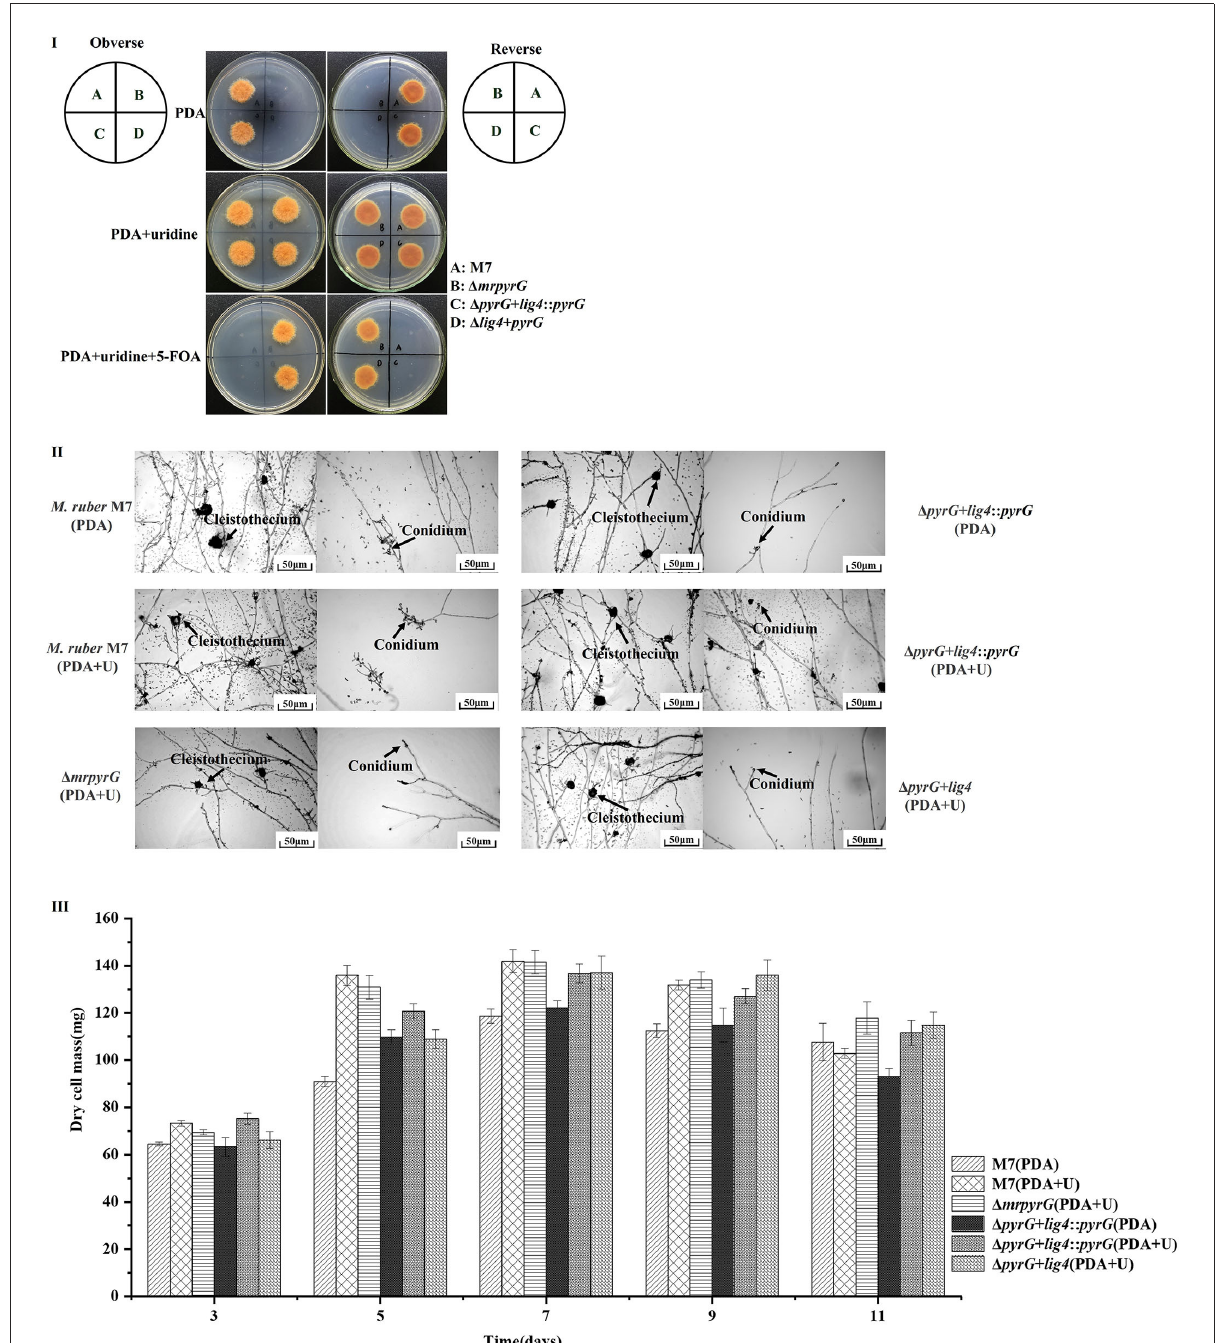
FIGURE3 Morphologies and biomasses of M. ruber M7 and derivative markerless deletion strains. (I) Colonial morphologies on PDA, PDA + U and PDA + U + 5-FOA plates. (II) Cleistothecia and conidia formation on PDA and PDA + U plates. (III) Biomass (dry cell weight).